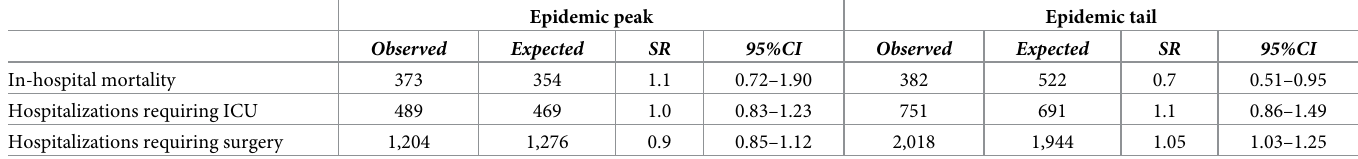
Table 4. Estimated standardized ratios (SR) for in-hospital mortality and for hospitalizations requiring ICU and surgery for the two considered epidemic periods (peak and